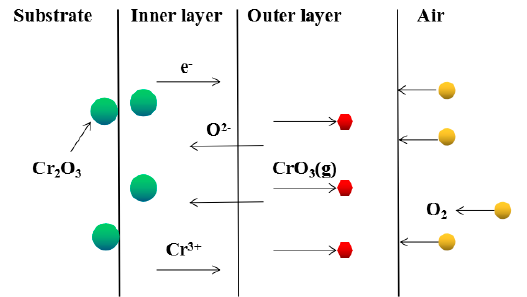
Figure 7. Schematic diagram of Cr 2 O 3 failure in Fe–10Cr steel at 1200 °C in air.